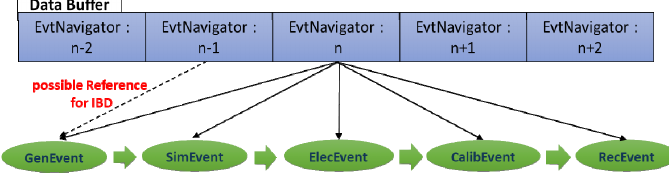
Fig.3. Event buffer management in